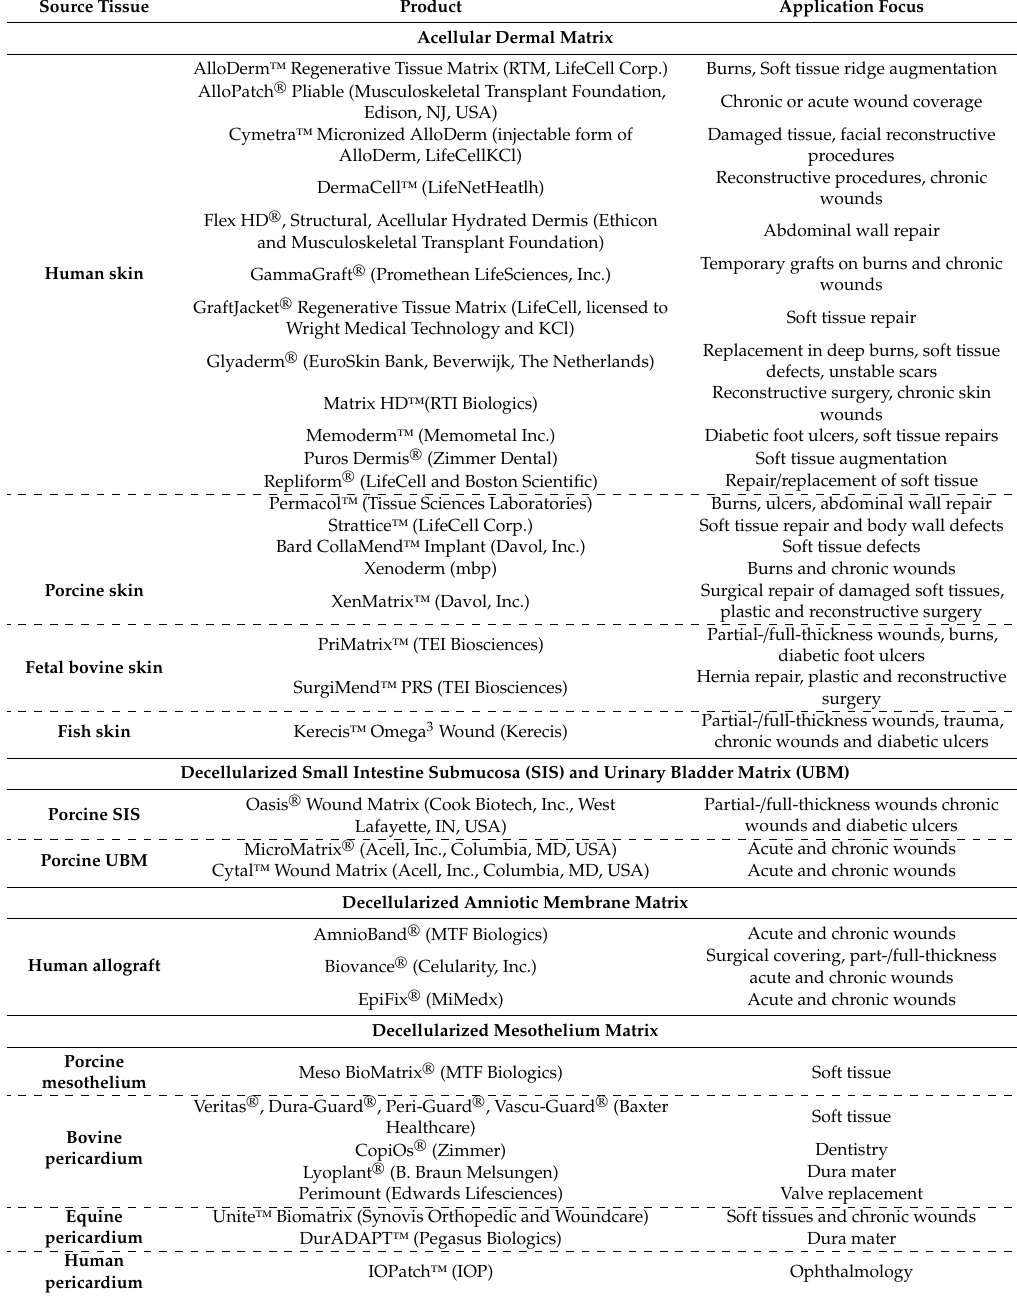
Table 1. Commercially available decellularized sca ff olds with potential use in skin